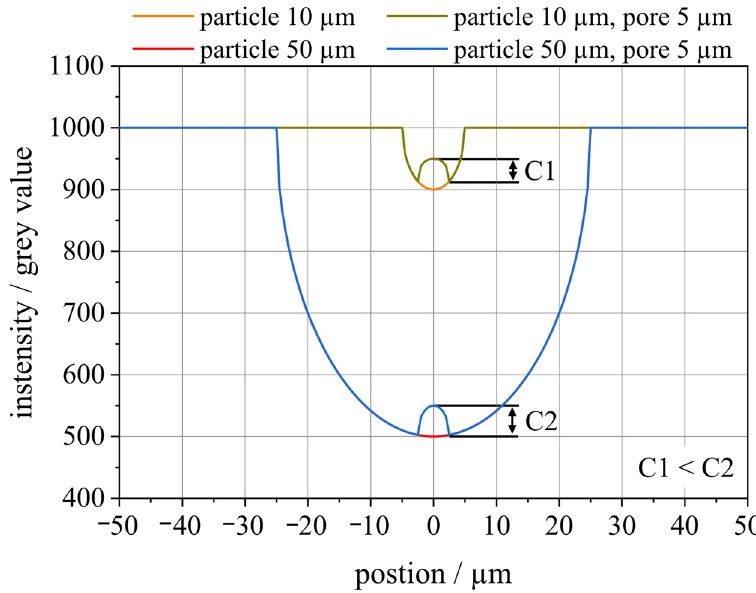
Figure 5. Contrast change as a function of the overlaid profiles of the pore and particle for different particle diameters. C1 is smaller than C2 for the same pore diameter, since the line profile of the larger particle (50 µm) is almost a flat plateau in contrast to the smaller particle.